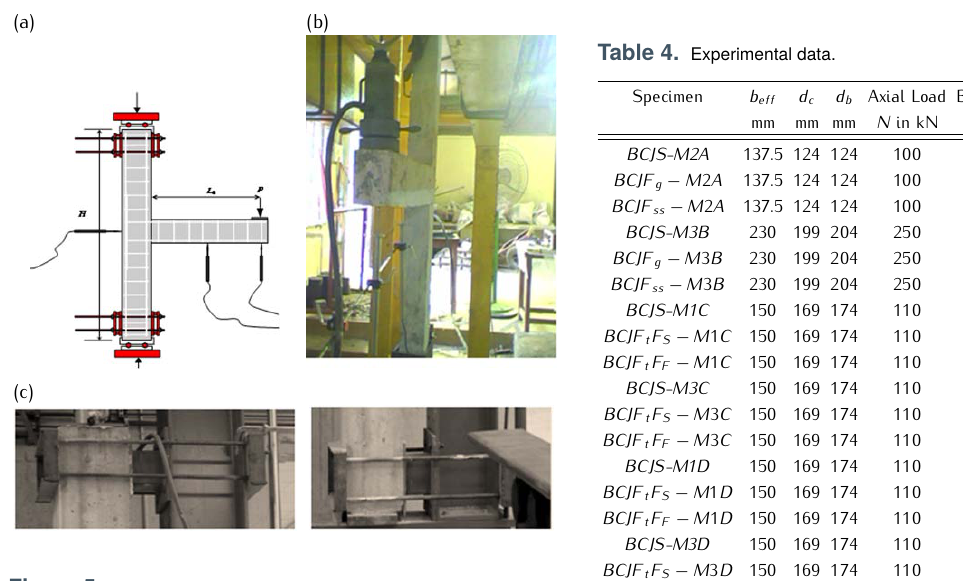
Figure 5. (a) Experimental set up; (b) Test set up with instrumenta- tion; (c) Lateral Support at top and bottom.